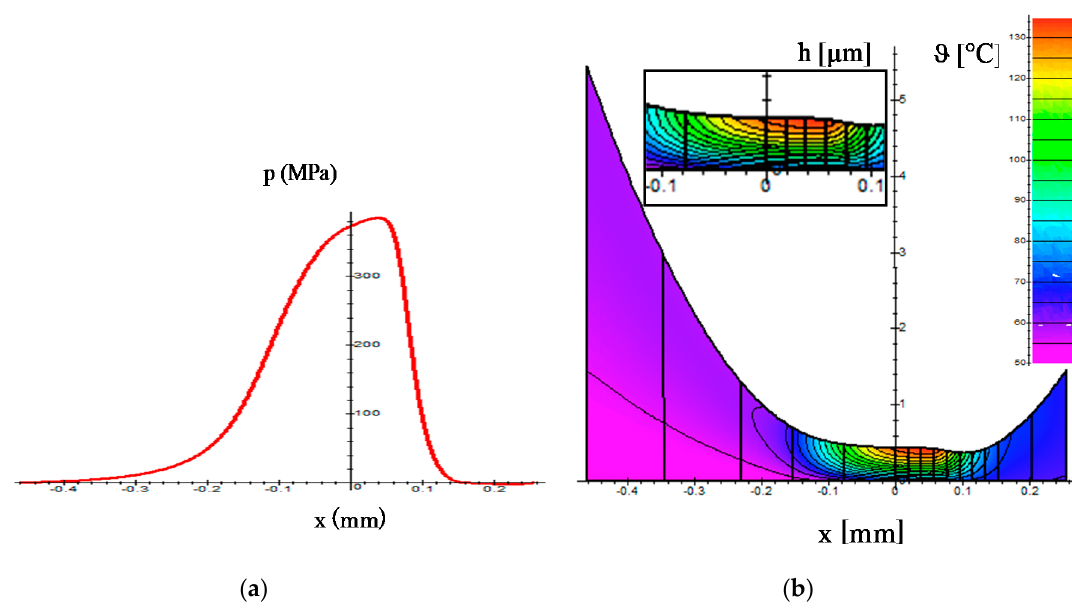
Figure 6. ( a ) Pressure distribution in the case of pure-sliding contact S = 2. ( b ) Temperature distribution in the case of pure-sliding contact S =